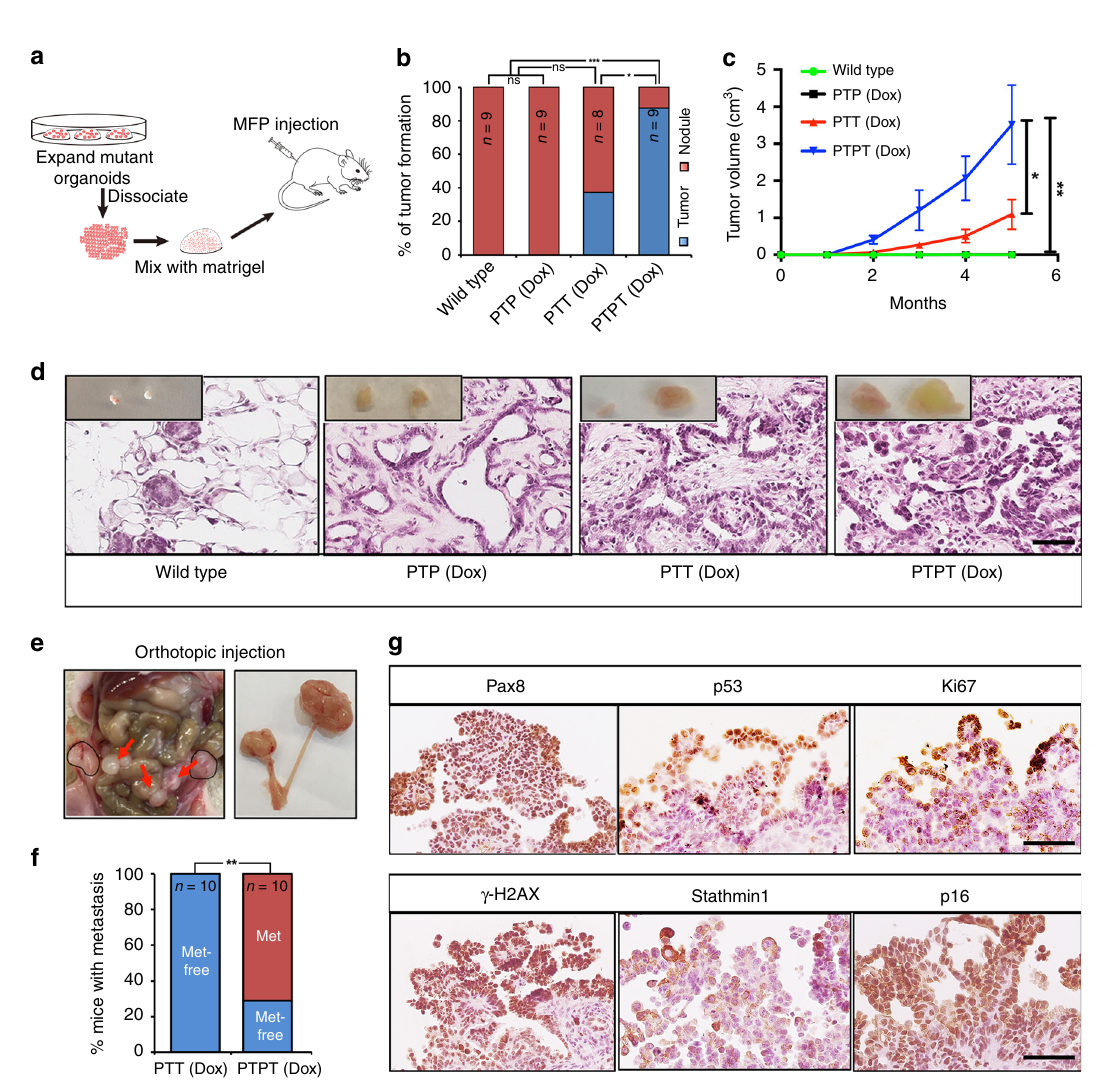
Fig. 3 Transplanted organoids recapitulate HGSOC progression and metastasis. a Scheme depicting mammary fat pad (MFP) transplantation. b % of tumors formed in MFPs within 6 months after injection of 10 5 cells from wild type, PTP, PTT, and PTPT organoids (all Dox-treated); ns, not signi fi cant, * P < 0.05, *** P < 0.001, Fischer ’ s exact test. c Graph showing the average tumor volume in MFPs injected with organoids of the genotypes indicated in b . Data represent mean ± SE, * P < 0.05, ** P < 0.01, two-way ANOVA; Source data are provided as a Source Data fi le. d H&E-stained sections of MFPs from mice injected with 10 5 cells from the indicated organoids, 3 months after injection; inserts show gross appearance of nodules/tumors. Scale bar, 50 μ m. e Left panel: exposed abdomen of mouse 3 months after orthotopic injection with 10 5 PTPT organoid cells, showing ovarian masses (circles) and widespread peritoneal metastasis (arrows). Right panel: genital duct dissected from the left panel shows large tumors on ovary. f % of mice injected with Dox-treated PTT (0%, n = 10) and PTPT (30%, n = 10) organoids that develop peritoneal metastasis, assessed at 6 months following injection of 10 5 organoid cells; ** P < 0.01, Fischer ’ s exact test. g H&E-stained sections and IHC for the indicated HGSOC markers in omental metastases; scale bar, 50 μ